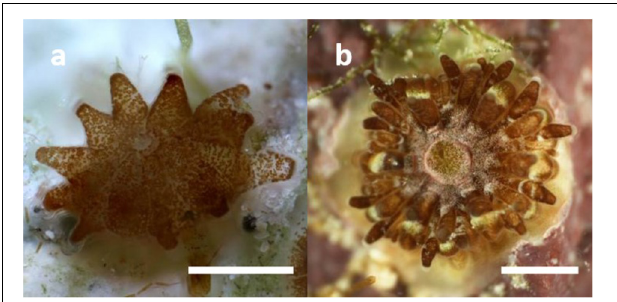
FIGURE 9 | Recruits of 4 weeks (a) and 8 weeks (b) post-settlement. Scale bar: 1 mm. Permission to publish these photographs has been obtained from Moeller et al.